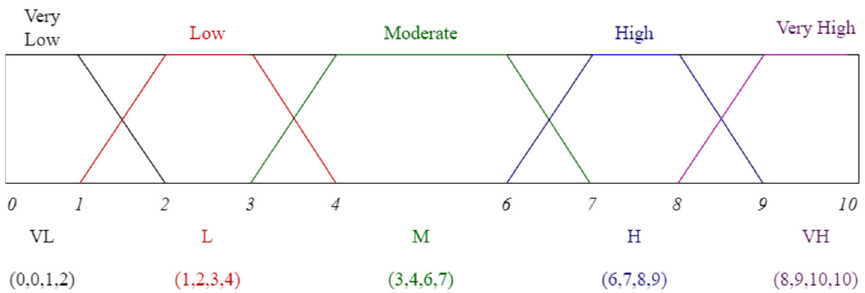
Figure 15. Linguistic scale in fuzzy terms.